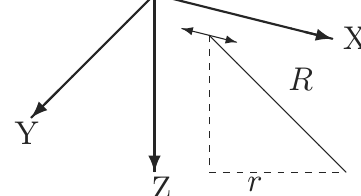
Fig. 1 – A x -directed electric dipole I dx 0 i at ( x 0 , y 0 , z 0 ) in a homogeneous isotropic and infinite medium. Observation point at ( x , y , z ). R represents the source-receiver distance, and r the horizontal projection of R